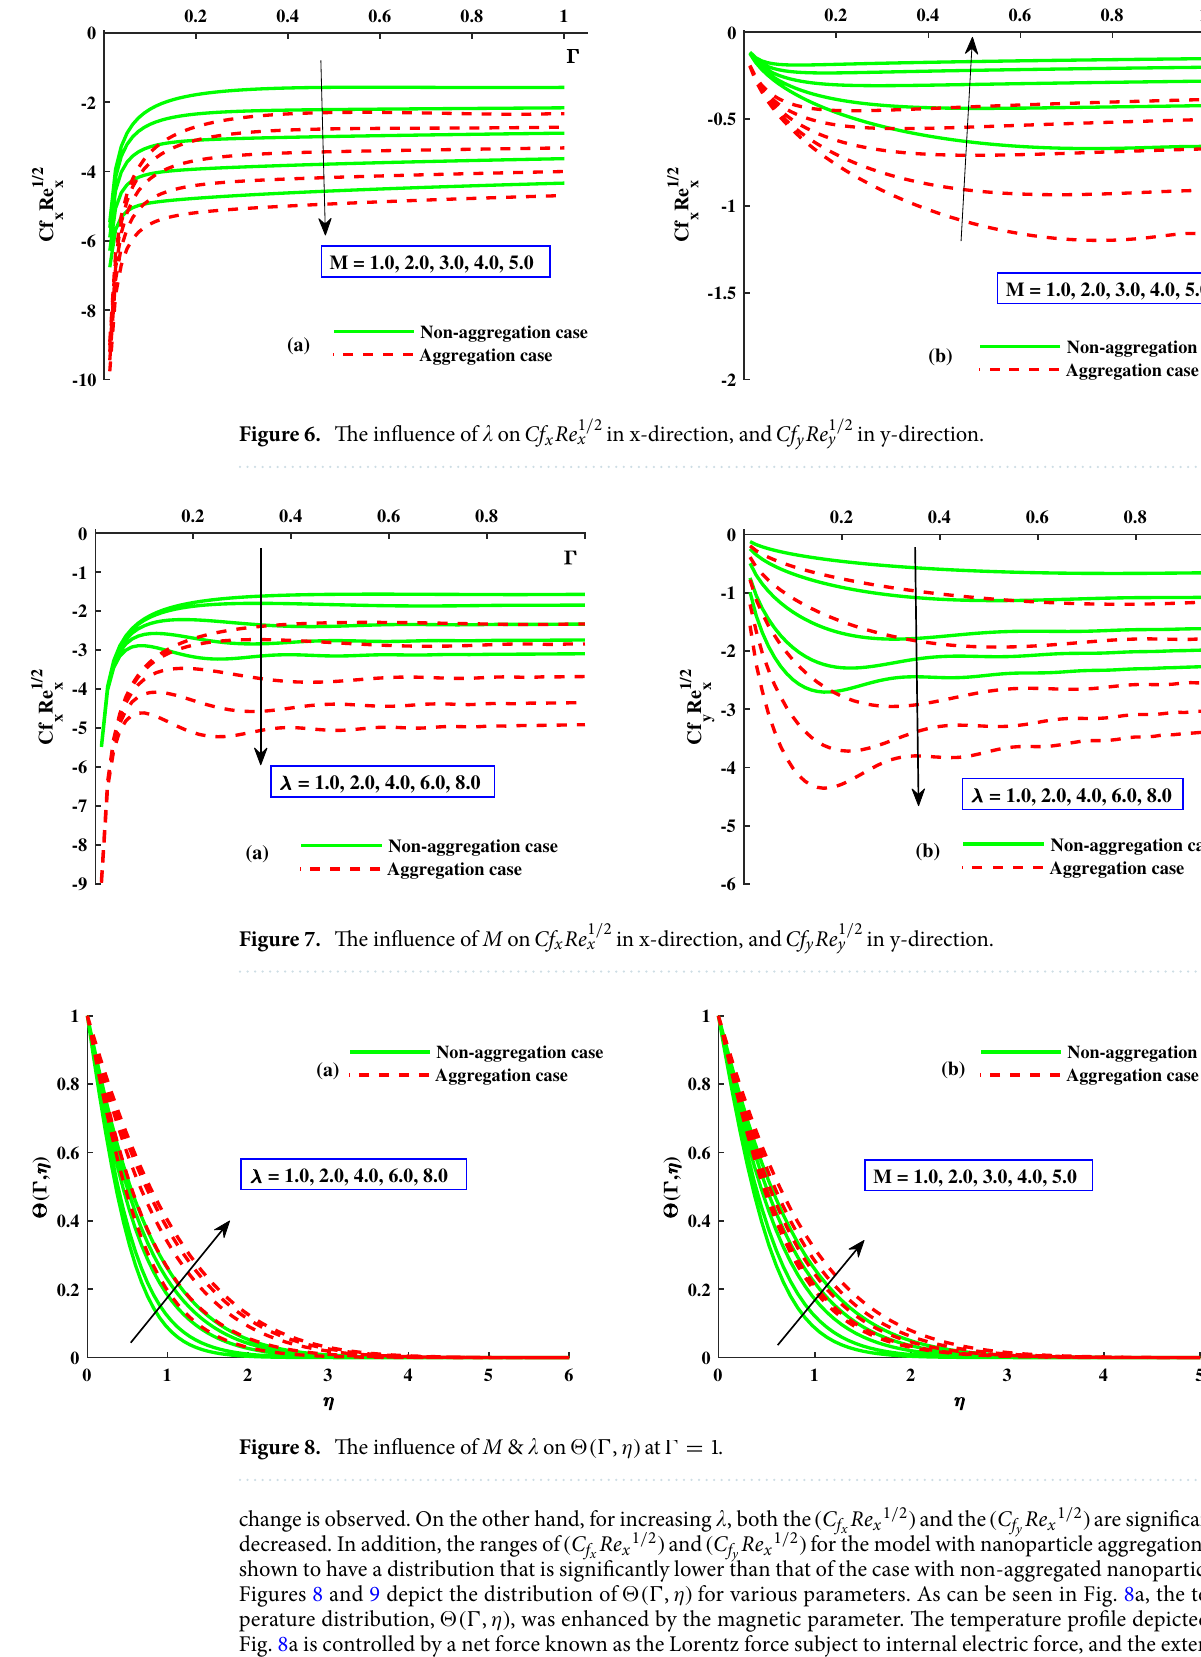
Figure 8. The influence of M & (cid:31) on �(Ŵ , η) at Ŵ